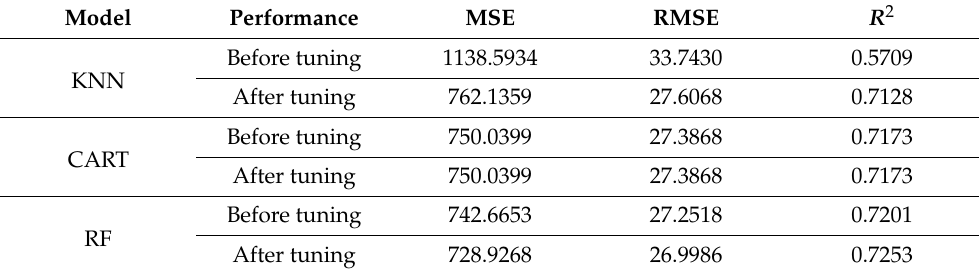
Table 10. Results of hyperparameter tuning using KNN, CART, and RF.